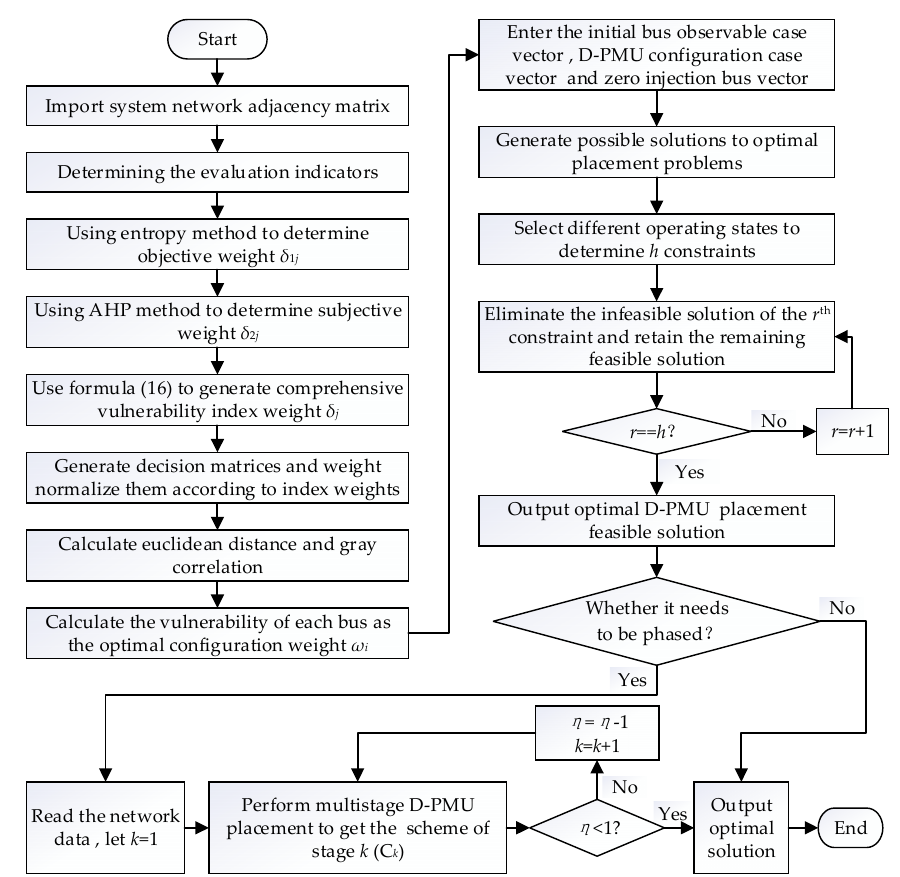
Figure 3. Flow chart of the optimal D-PMU placement process.